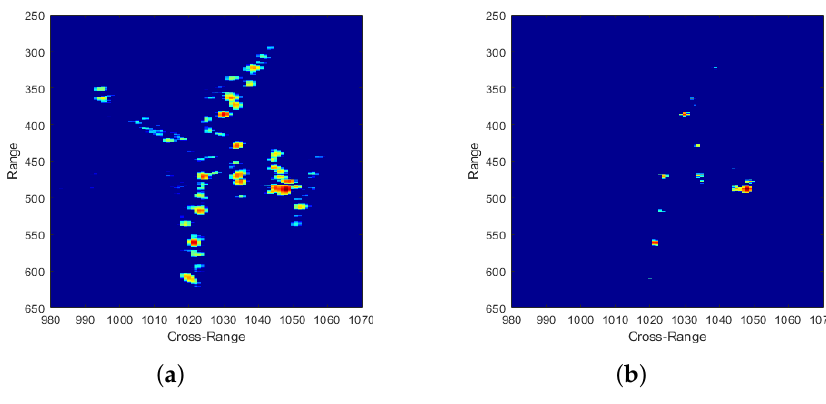
Figure 11. Imaging results of ( a ) CIST and ( b )